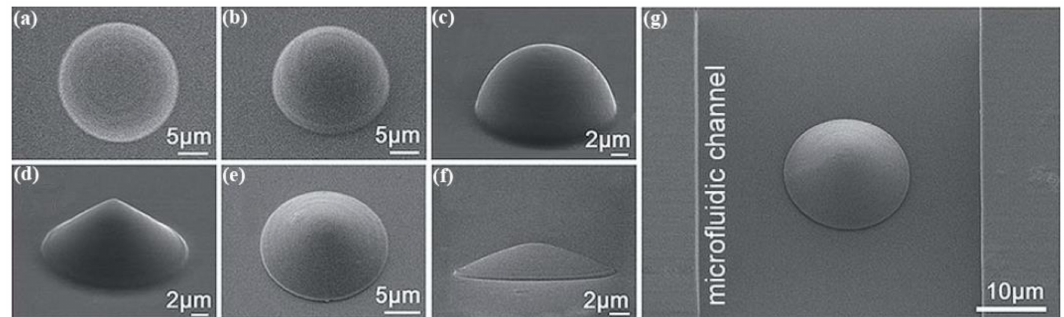
Figure 9. The SEM images from different view angles of ( a–c ) Spherical microlens and ( d–f ) aspheric hyperboloid microlens; and ( g ) SEM image of the microfluidic channel integrated with microlens [65].